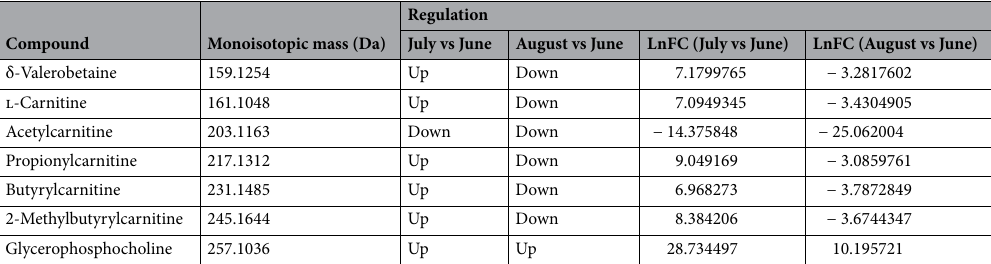
Table 3. Metabolites obtained from LC–MS data (positive mode), that are differentially accumulated in milk samples from buffaloes of DD Group (fed a total mixed ratio (TMR)) for the whole experimental period (June, July and August). Identifications were performed by comparing results with known compounds present in freely available electronic databases. Milk Composition Database (MCDB) and Bovine Metabolome Database (BMDB) were used for the identification. Up, up regulated; Down, down regulated. LnFC, Natural logarithm of Fold Change.